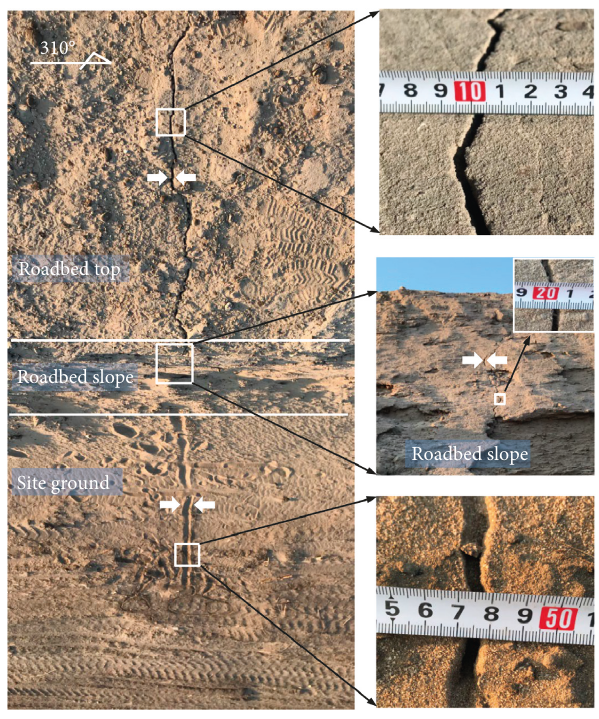
Figure 16: Top view and crack detail of the roadbed and